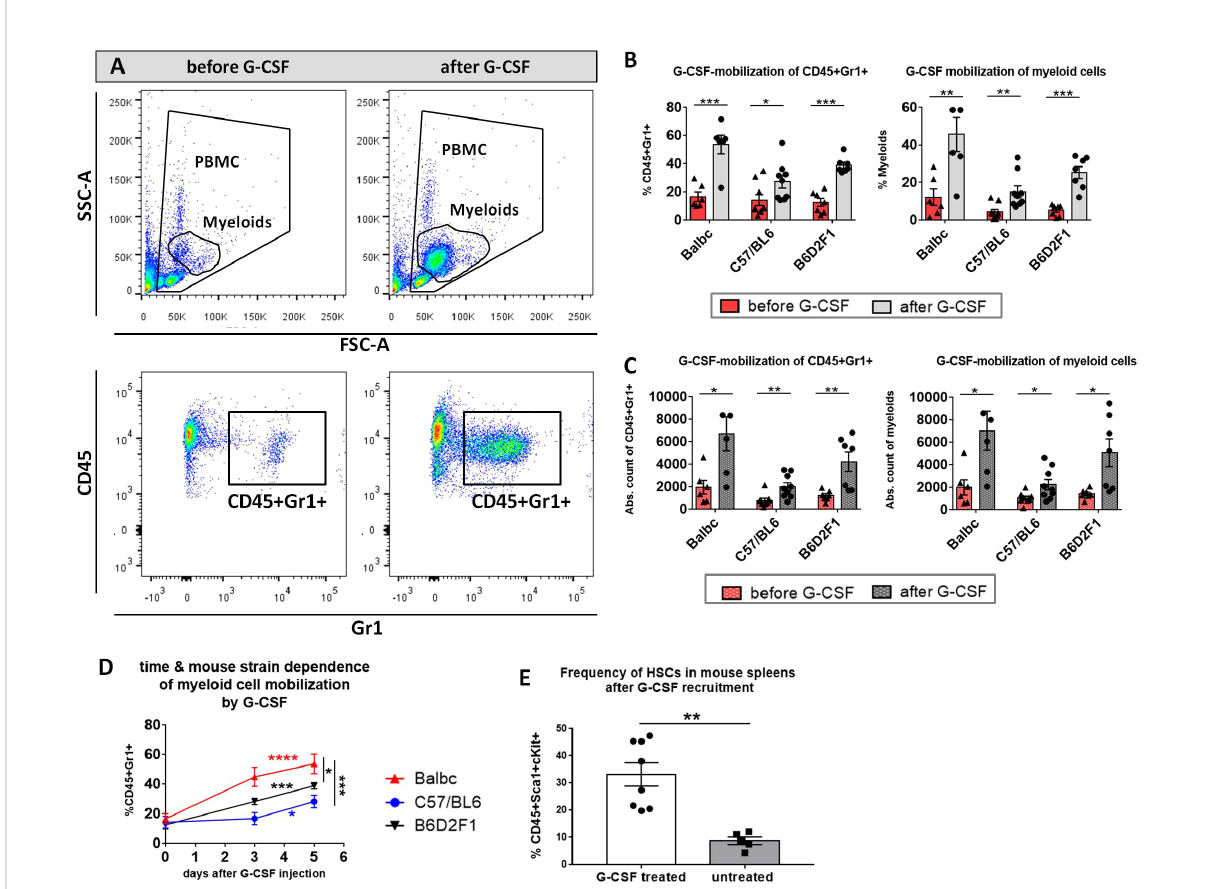
FIGURE 1 Myeloid cell-mobilization by G-CSF in peripheral blood of Balb/c, C57BL/6 and B6D2F1 mice. (A) FACS gating strategy of unstained myeloid cells in FSC/SSC and of stained CD45+Gr1+ cells. Example of a visible increase in myeloids and CD45+Gr1+ cells after 5 consecutive days 10 µg G-CSF injection in a BDF1-mouse. (B) Signi fi cant increase in % CD45+Gr1+ and % myeloids and (C) in the absolute cell count of CD45+Gr1+ and myeloids in the peripheral blood of different mouse strains before and after 5 day G-CSF treatment. (D) Temporal rise of % CD45+Gr1+ cells in the peripheral blood of different mouse strains from day 0 to 5 of G-CSF injection. Balb/c: n=6, BDF1: n=7, C57BL/6: n=9. (E) Frequency of CD45+Sca1+cKit+ HCs in the spleen of untreated vs. G-CSF treated mice. Cell frequencies were determined from isolated FACS-stained whole spleen PBMCs with or without 10 µg G-CSF treatment for 5 days. Pooled BDF1 (n=3), Balb/c (n=2) and C57BL/6 (n=3). Data pooled from three independent experiments. Error bars indicate mean+SEM. *P<0.05, **P<0.01, ***P<0.001, ****P<0.0001 by Holm-Sidak test (B, C) and unpaired students t-test with a =0,05 (D, E)